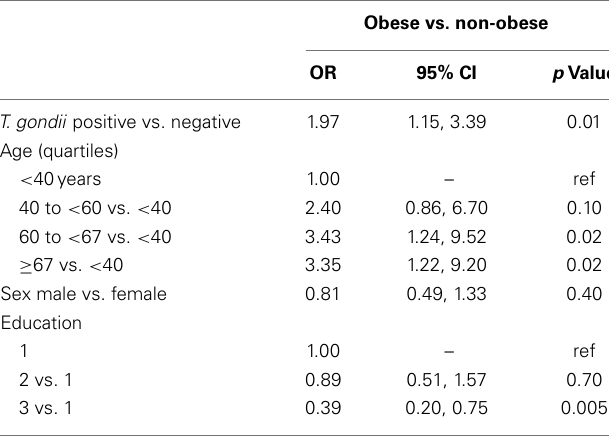
Table 2 |Age-adjusted odds ratios for obesity (BMI ≥ 30) compared